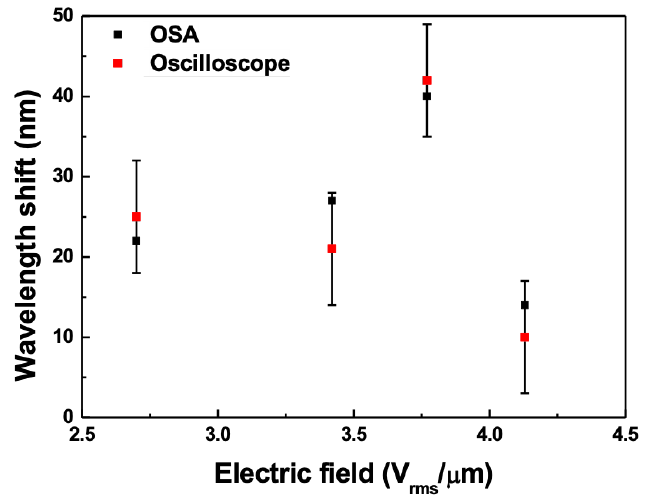
Figure 8. Wavelength shift of the short-band edge on the OSA and oscilloscope when a pitch jump occurs according to the electric field applied to the CLC cell.